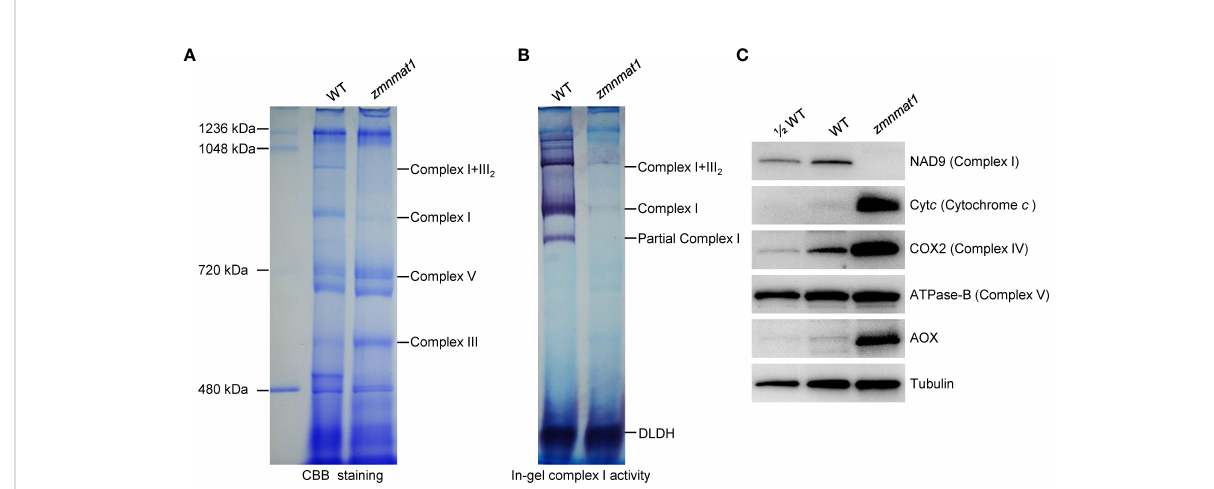
FIGURE 7 Impacted mitochondrial complexes in zmnmat1 kernels at 10 DAP. (A) BN-PAGE analysis of mitochondrial complexes. The positions of complex I+III 2 , complex I, complex III and complex V were indicated. About 100 m g of mitochondrial protein was loaded in each lane. (B) In-gel NADH dehydrogenase activity test of complex (I) The positions of complex I+III 2 and complex I was indicated. About 100 m g of mitochondrial protein was loaded in each lane. (C) Western blot analysis with antibodies against NAD9 (subunit of complex I), Cyt c (Cytochrome c ), COX2 (subunit of complex IV), ATPase-B (subunit of complex V) and AOX2 (stands for alternative oxidase) in mitochondrial protein from WT and zmnmat1 immature seeds at 10 DAP. Tubulin was used as a loading control. About 25 m g of mitochondrial protein was loaded in WT and zmnmat1 lanes, and about 12.5 m g of mitochondrial protein was loaded in ½WT